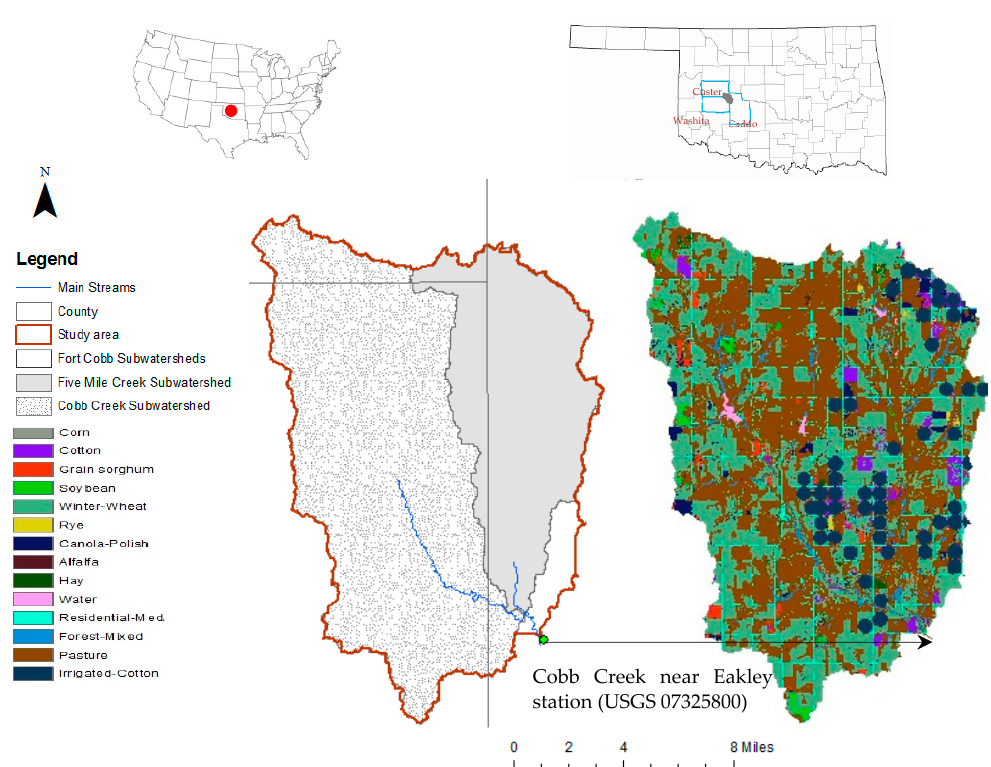
Figure 2. Five Mile Creek and Cobb Creek sub-watersheds within Forb Cobb Reservoir watershed located in three counties of Southwestern, OK, USA.